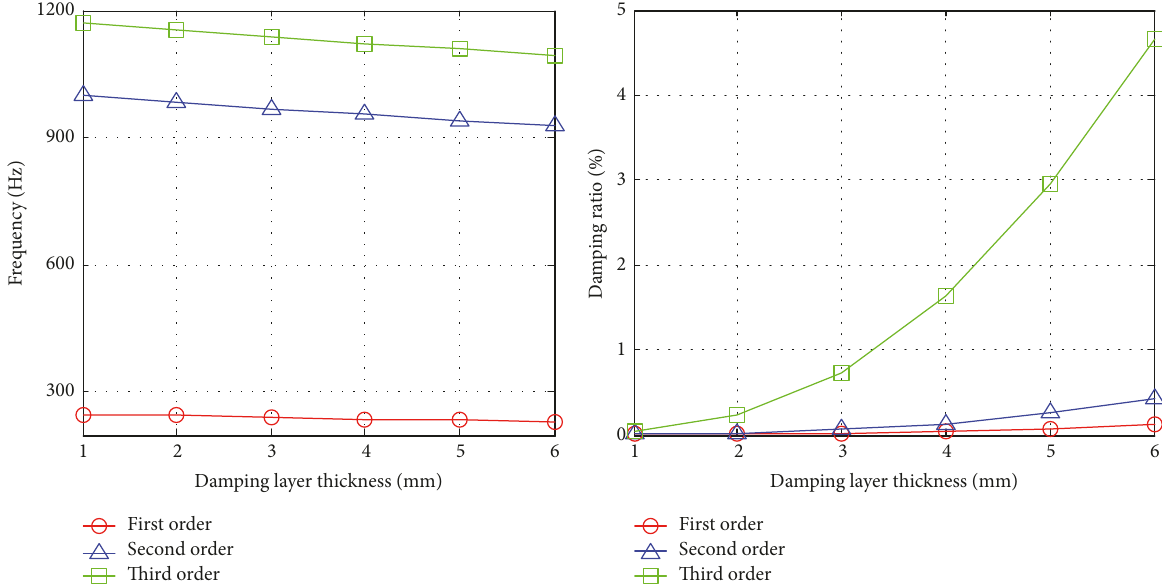
Figure 7: The thicknesses of viscoelastic damping block on the influence of natural frequencies and modal damping ratio of the blade.